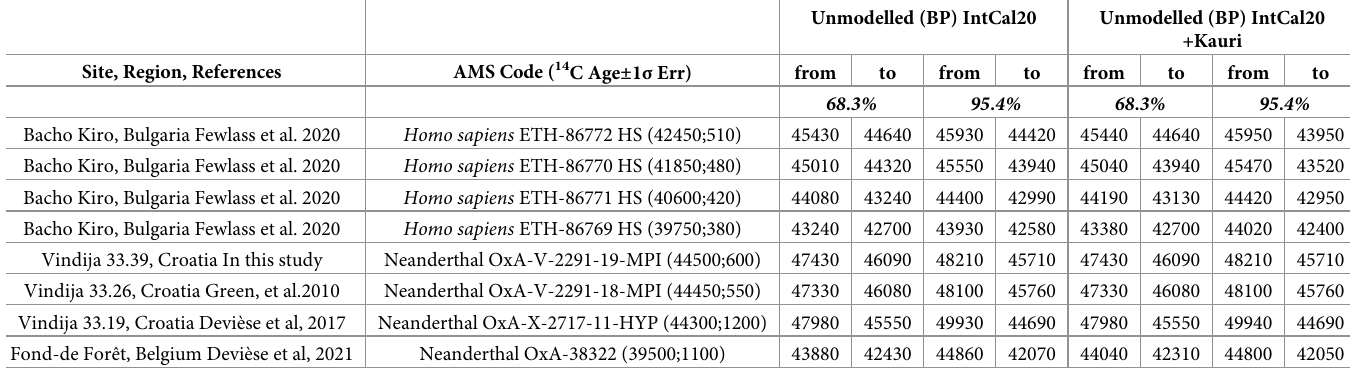
Table 1. Radiocarbon ages of the directly dates of 4 Homo sapiens from Bacho Kiro, 4 Neanderthals from Fond-de For ê t and Vindija. The respective calibrated results using both IntCa20 [31] in OxCal4.4 [58] and IntCal 20+Kauri